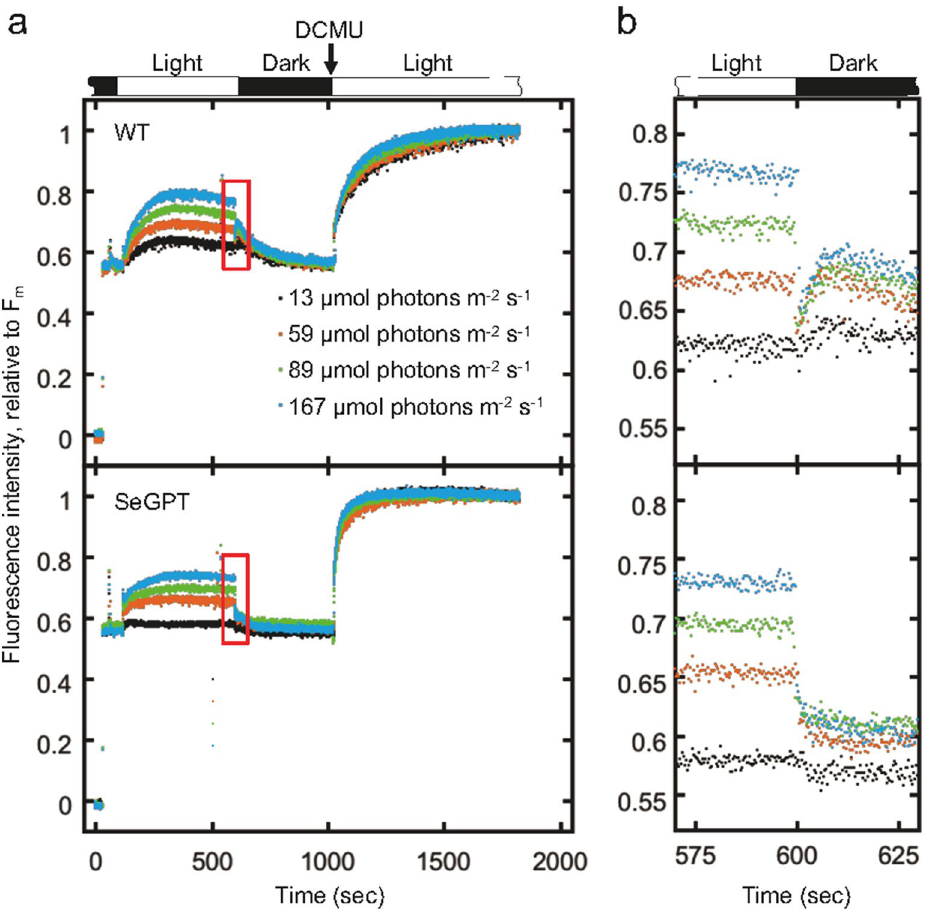
Figure 6. Pulse amplitude–modulated chlorophyll fluorescence measurements. Before fluorescence was measured in the dark (F 0 ), cells were dark-acclimated for 10 min. Actinic light at different light intensities was irradiated for 8 min, which was followed by dark relaxation for 7 min. To achieve the maximum fluorescence (F m ), 10 µM of DCMU was added to the cell suspension and irradiated with actinic light. Representative fluorescence kinetics are shown as relative values normalized to the F m . The transient increase in fluorescence immediately after turning off actinic light is shown in the red box ( a ), which is enlarged in ( b